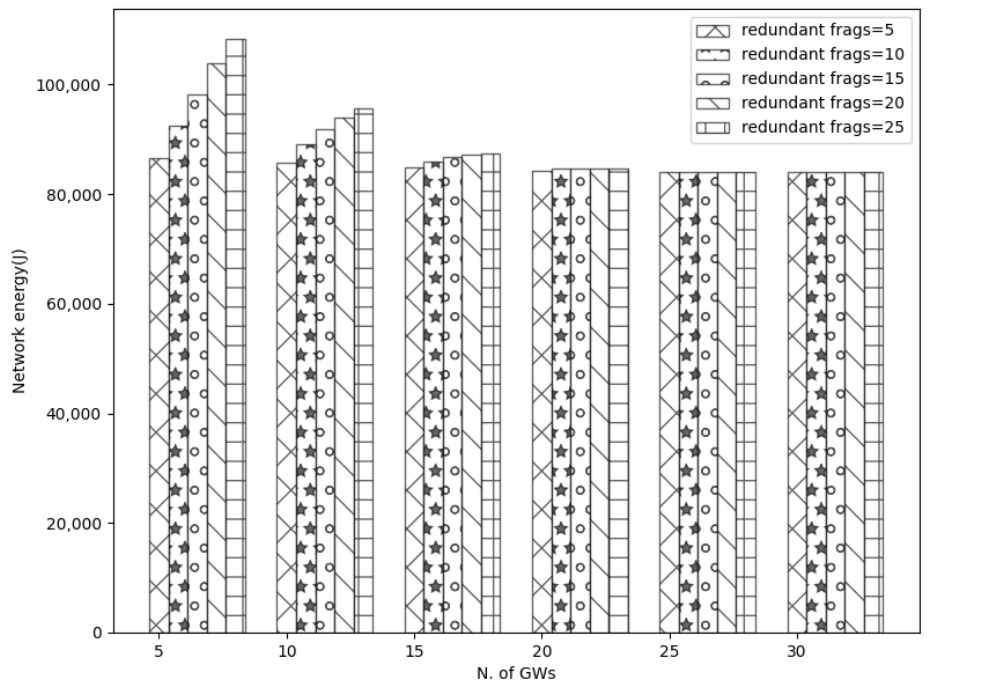
Figure 11. Effect of redundant fragments in network